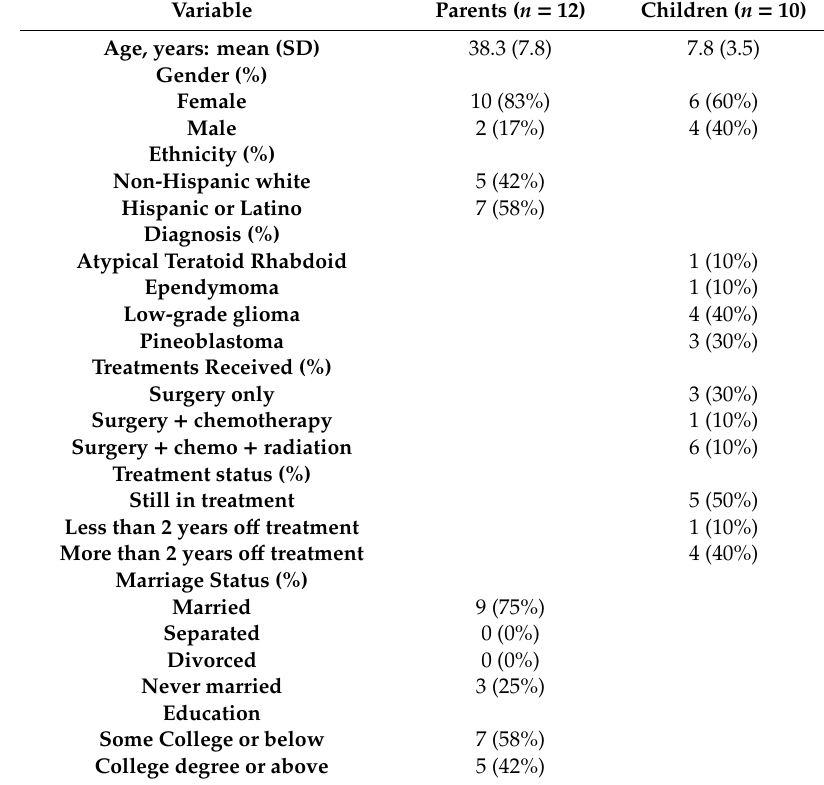
Table 1. Parent demographics and children’s clinical